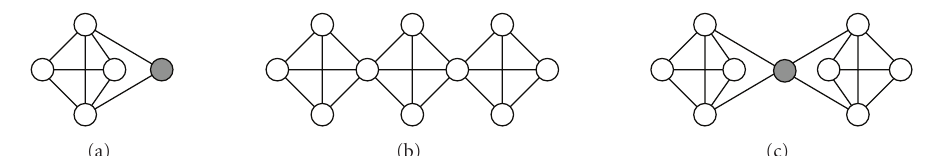
Figure 1: Near-cliques of types A, B, and C. Proteins outside a clique are represented as shaded nodes.